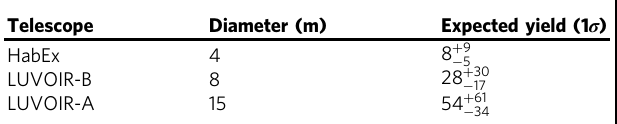
Table 2 The number of expected Earth-like exoplanets observed by each platform from the HabEx 30 and LUVOIR 31 fi nal